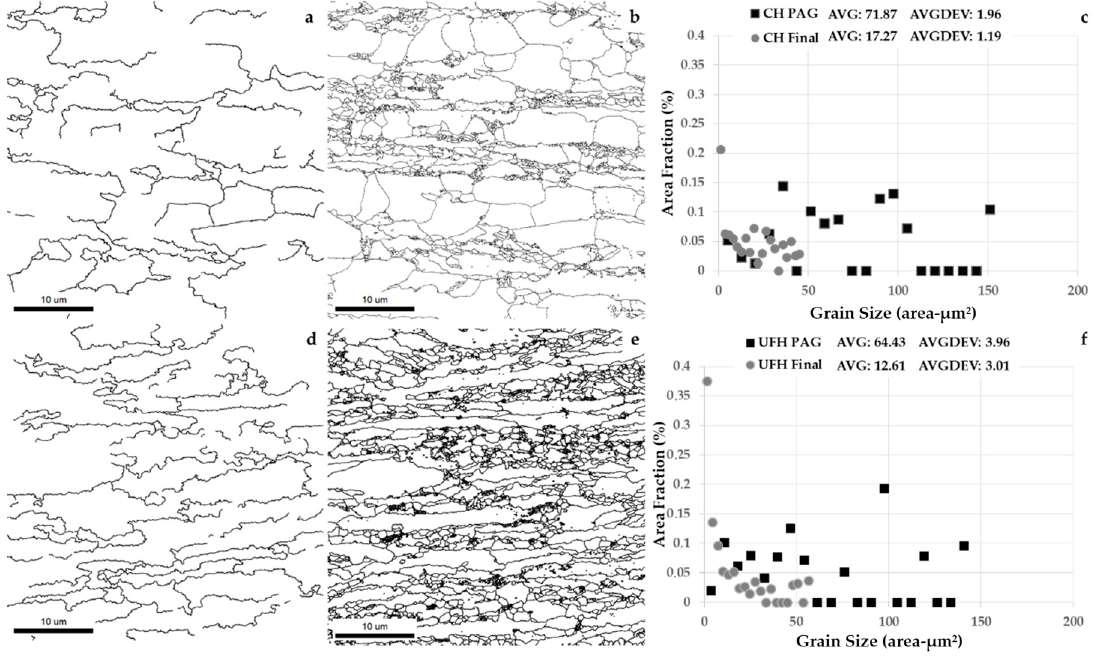
Figure 11. ( a ) Grain boundary (GB) map of the reconstructed PAGs of the CH sample with the use of the ARPGE [29] software, ( b ) GB map of the reconstructed PAGs of the UFH sample with the use of the ARPGE [29] software, ( c ) grain size chart for the PAGs of both samples indicating the refinement of austenite in UFH sample, ( d ) GB map of the final microstructure of the CH sample, ( e ) GB map of the final microstructure of the UFH sample, and ( f ) grain size chart for the final microstructure of both samples indicating the refinement of grains and laths in the UFH sample.